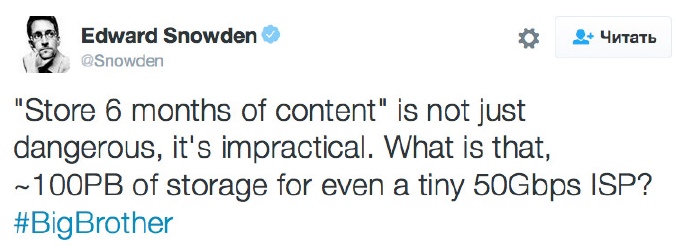
Figure 2. Edward Snowden’s critical tweet on the duration of data storage outlined in the Yarovaya law. While SORM and Yarovaya law give FSB access to data stored on Russian servers without informing site